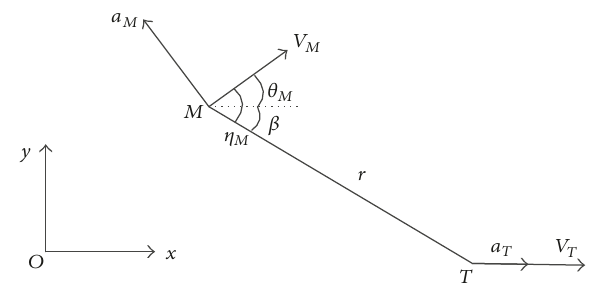
Figure 1: Planar missile-target